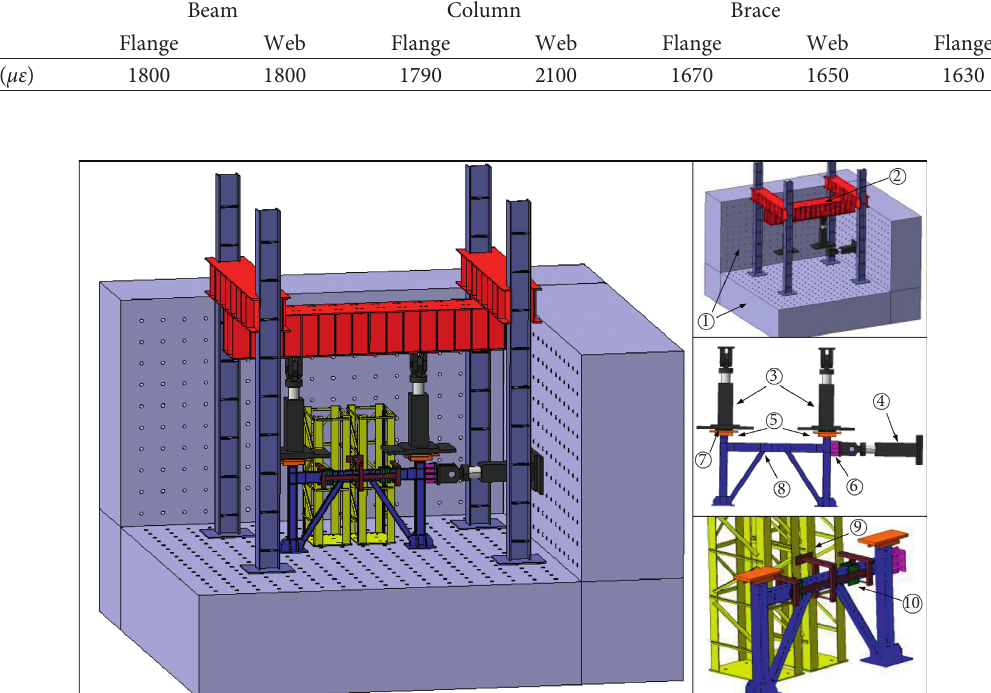
Figure 4: Test model. (1) Floor and reaction wall; (2) reaction frame; (3) 2 × 2000 kN actuator; (4) 1000 kN actuator; (5) columns support; (6) loading plate; (7) column base bearing; (8) test specimen; (9) support truss; (10) lateral